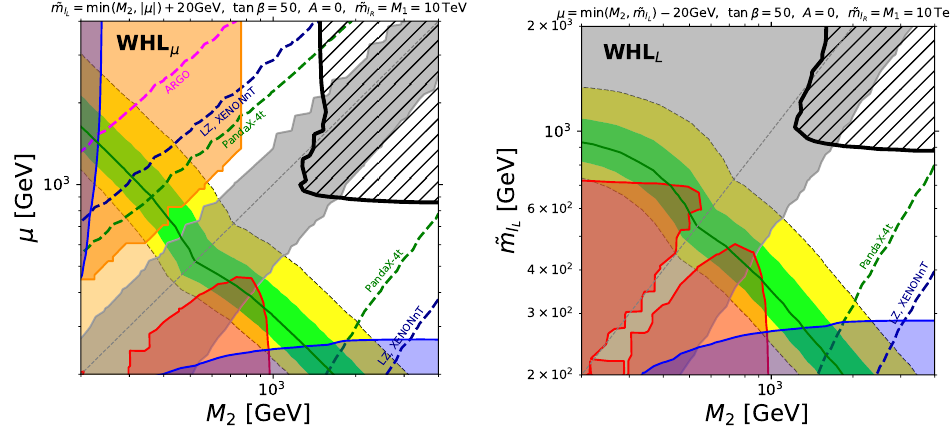
Figure 2 . Results for MSSM WHL µ (left) and WHL L (right) planes. Region of parameter space allowed by the latest a experimental results [4] is depicted with green and yellow bands, µ corresponding to one and two sigma agreement respectively. The bottom left region shaded by the dull yellow colour corresponds to a bigger than experimental value by more than 2 sigma. Hatched µ region is excluded by dark matter abundance criterion. Blue and red shaded regions are excluded by LHC constraints. Light grey shaded area is excluded by Xenon1T experiment. Expected exclusion range by future DDMD experiments is also shown with appropriately labelled